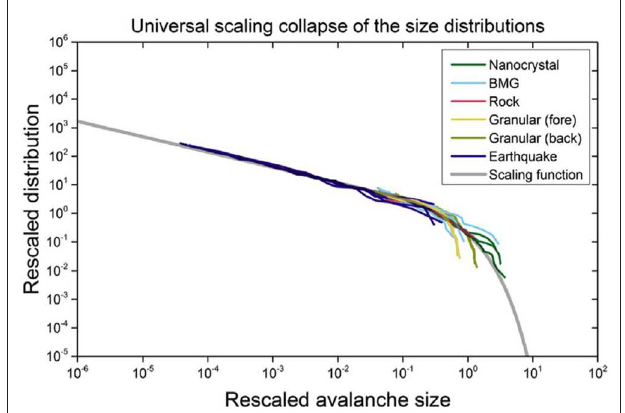
FIGURE 8 | Scaling collapse of the slip statistics (size CCDF) from different stress-windows of five different materials on scales spanning 12 decades in length, onto each other and onto the predicted scaling function of the mean-field model (see [ 5] and references therein for details) [Reprinted